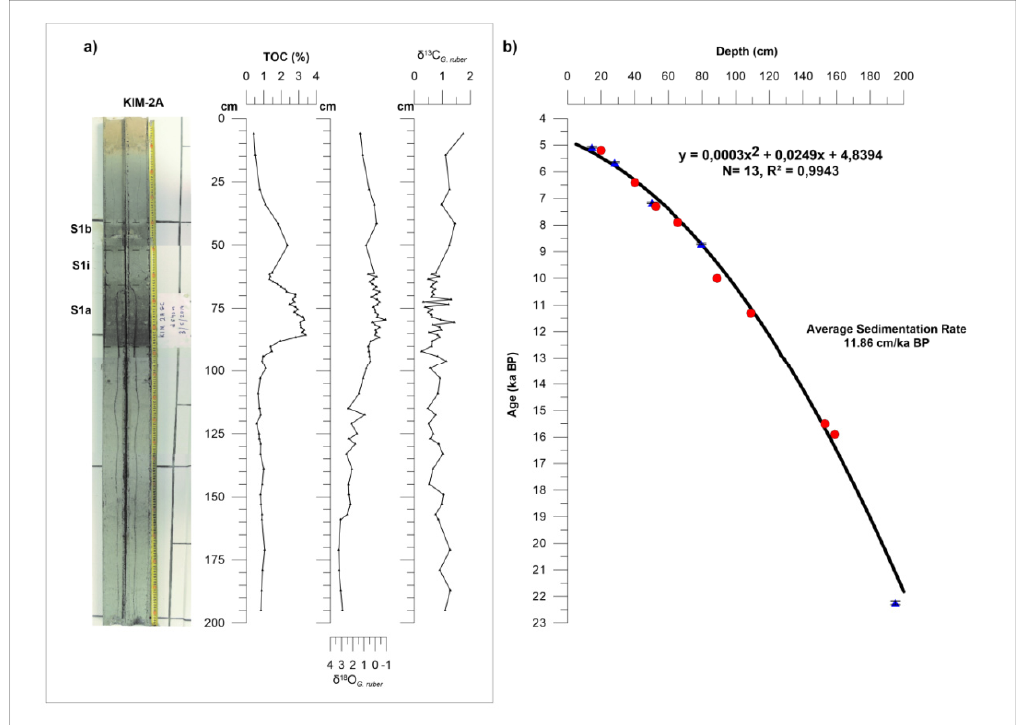
Figure 2. ( a ) Lithologic log of core KIM-2A along with the total organic carbon (TOC) concentration and δ 18 O G. ruber and δ 13 C G. ruber isotope values; ( b ) time stratigraphic framework of the study core; blue triangles represent AMS 14 C datings, whereas red dots represent control points and bio-litho-stratigraphic horizons used as stratigraphic markers. The errors of AMS 14 C datings are also shown.